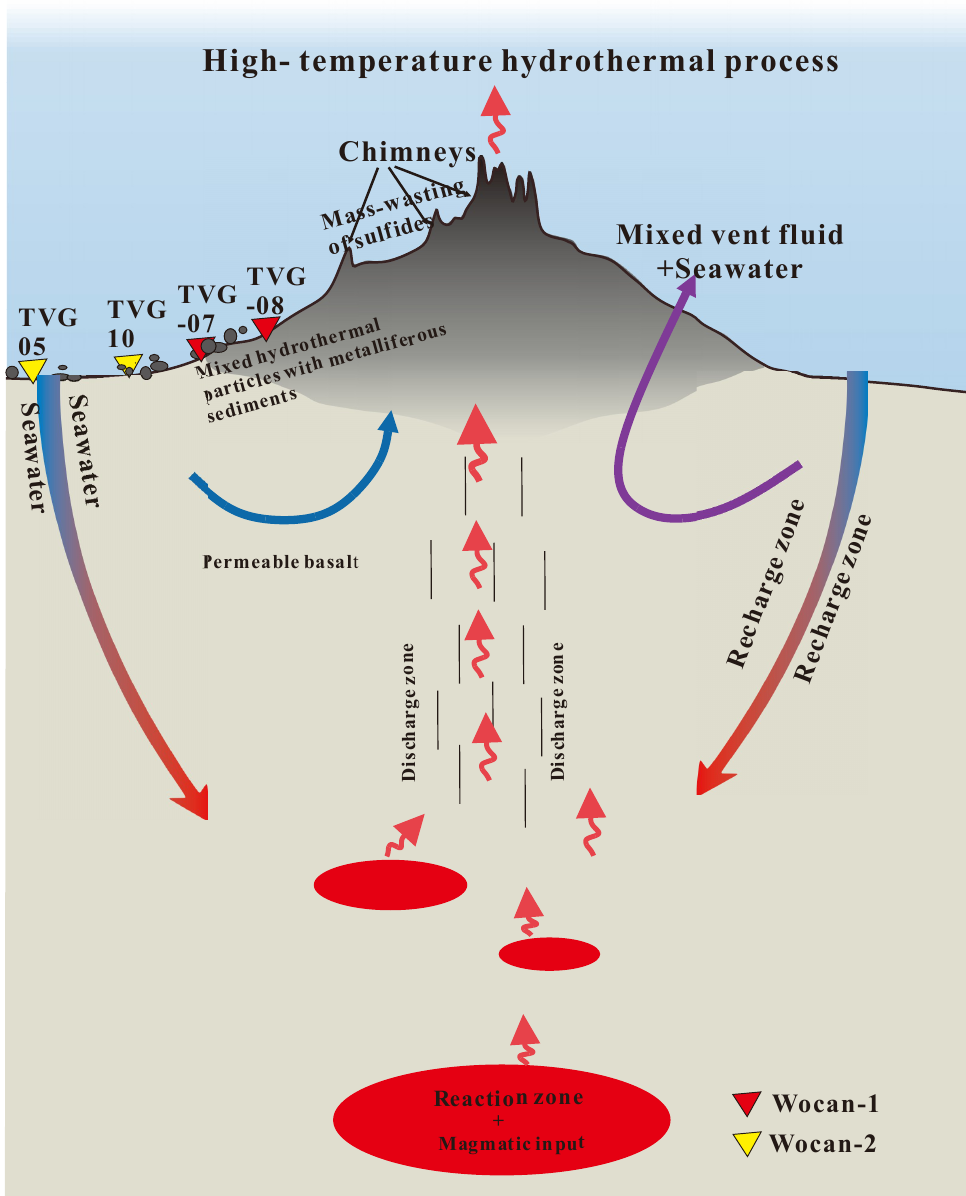
Figure 4. Schematic diagram showing the probable location of Wocan-I and Wocan-2 stations relative to high temperature seafloor hydrothermal systems, modified from Reference [10].